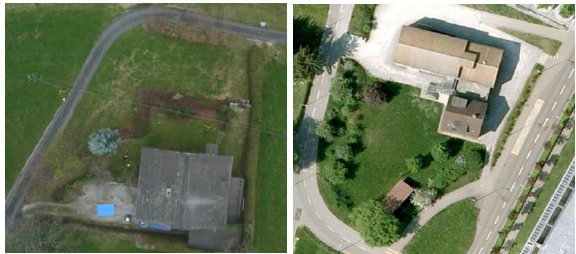
Figure 1. Left: Overview image of the test area Krattigen/BE, Right: Image with the test site Campus Science City ETH Hoenggerberg/ZH. Both images were taken from a camera mounted on a